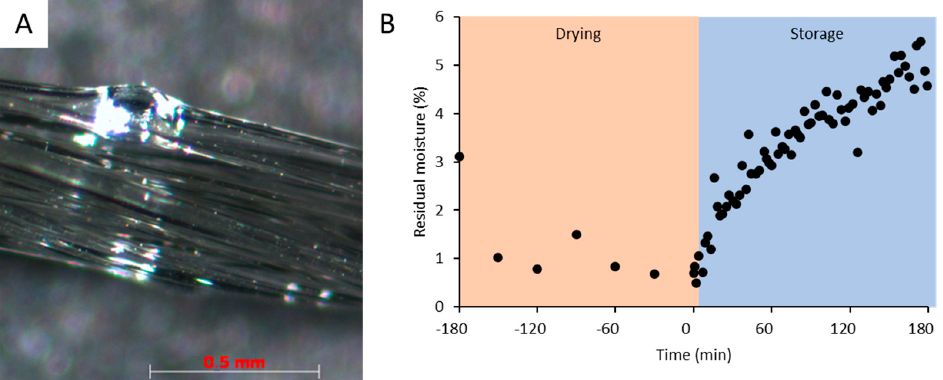
Figure 6. ( A ) Inhomogeneity in the extrudate due to residual water in the polymer during extrusion. ( B ) Residual moisture determination of pure PVA Parteck MXP at 105 °C after 3 h of drying followed ( B ) Residual moisture determination of pure PVA Parteck MXP at 105 ◦ C after 3 h of drying followed by 3 h of storage at room temperature at 52% r.h. by 3 h of storage at room temperature at 52%